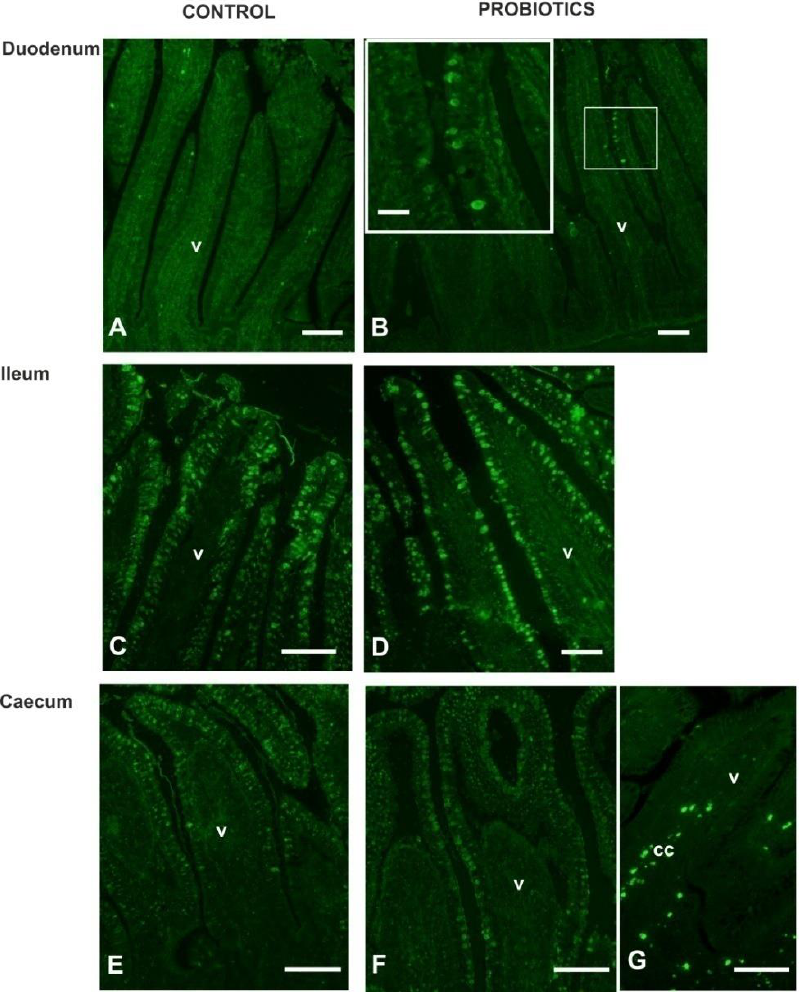
Figure 8. Reactivity pattern of SNA ( A – F ) and MAL II ( G ) with intestinal mucosa of guinea fowls. Inset of B shows magnification of the square-marked zone. cc, connective tissue cells. Scale bars: A–G, 100 µm.